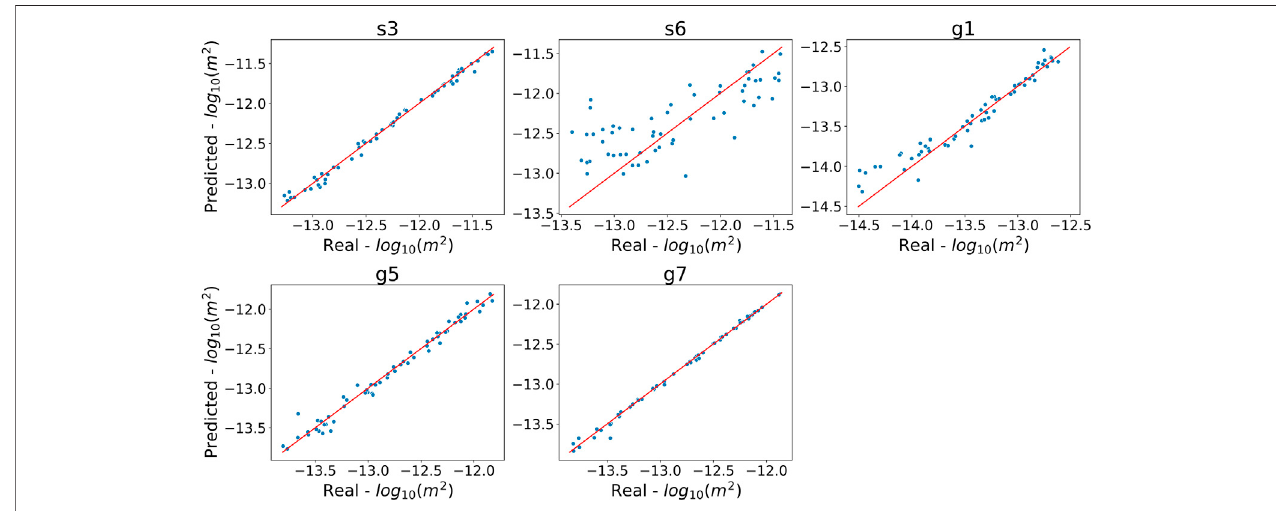
FIGURE 5 | One-to-one plot for permeability estimated from the DNN A3 model against the true permeability in the testing set. Each plot isfor a given permeability parameter, and each data point represents a realization from the testing set. The x -axis is the log 10 real permeability value, the y-axis is the log 10 estimated permeability value from the model. The red line is the one-to-one line.